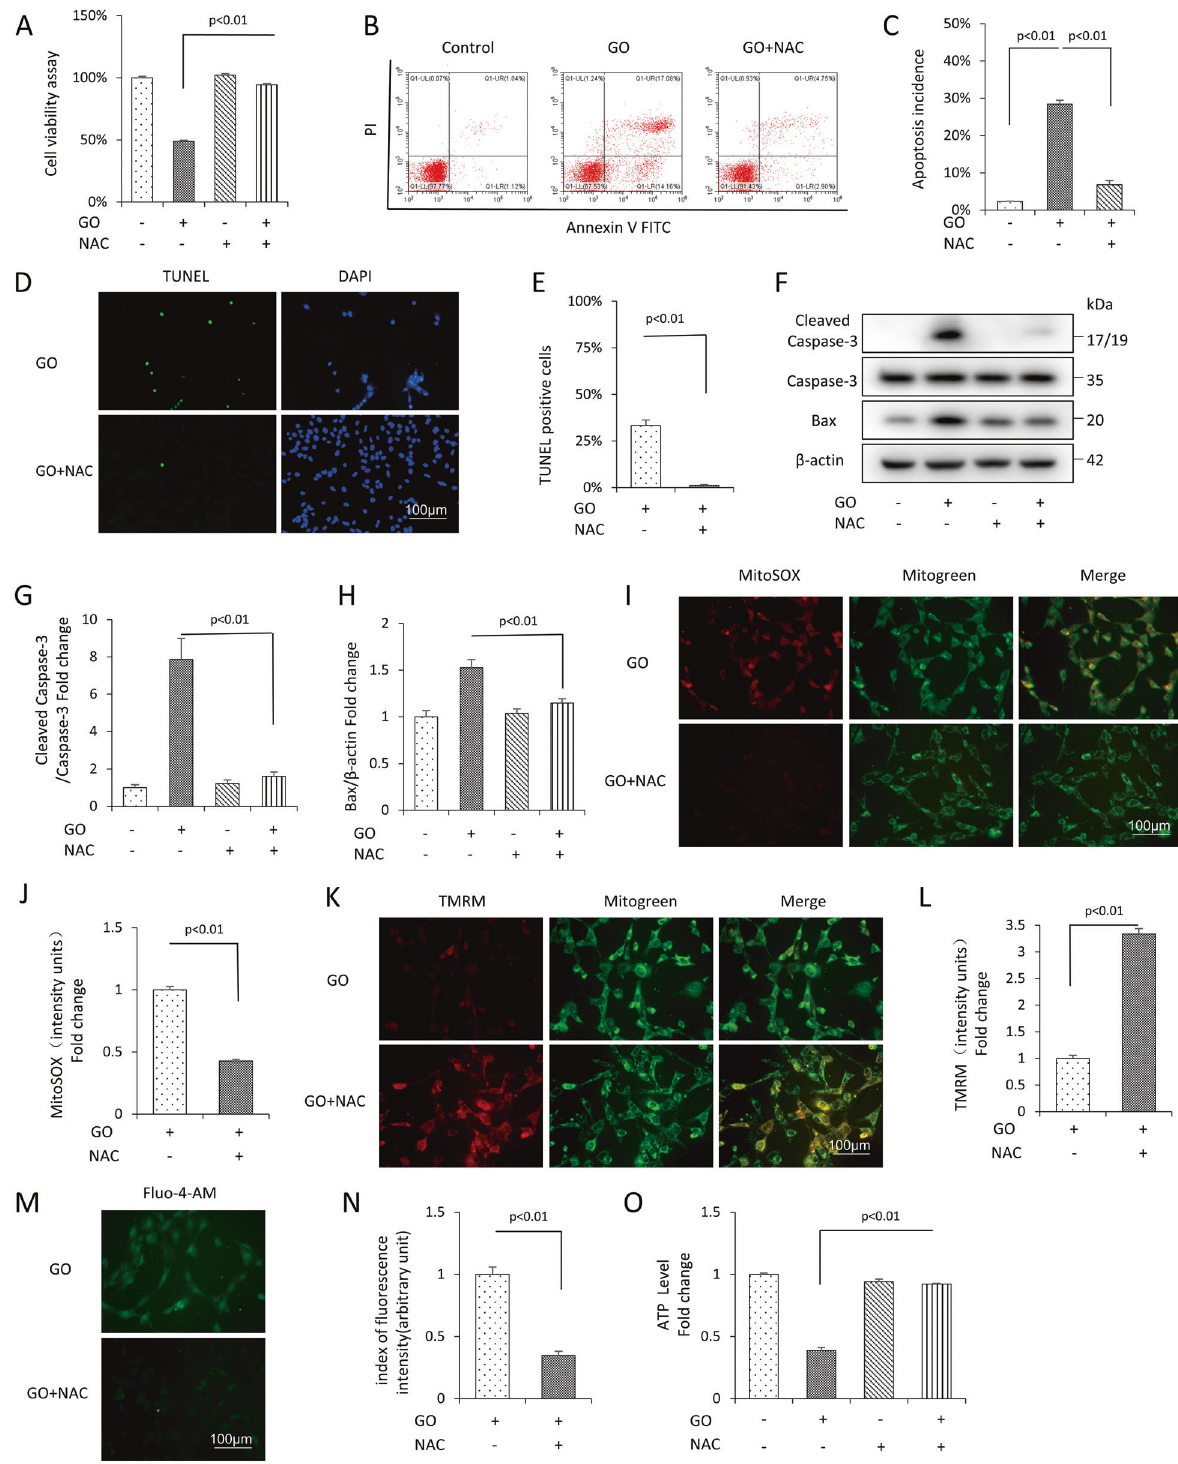
Fig. 4 The antioxidant NAC attenuated glucose oxidase-induced apoptosis and mitochondrial oxidative damage in mDPC6T cells. A Cell viability determined by CCK8 assay in the presence of glucose oxidase with or without NAC. B , C Flow cytometric quanti fi cation of apoptosis. D , E TUNEL staining and assay after NAC treatment. F – H Protein level of cleaved Caspase-3, Bax by Western blot and quanti fi cation analysis. MitoSOX staining ( I ) and quanti fi cation ( J ) in the indicated groups. TMRM staining ( K ) and quanti fi cation ( L ) in the indicated groups. Fluo-4-AM staining ( M ) and quanti fi cation ( N ) in the indicated groups. O ATP in the indicated groups. The values are expressed as the means ± SD ( n = 3).